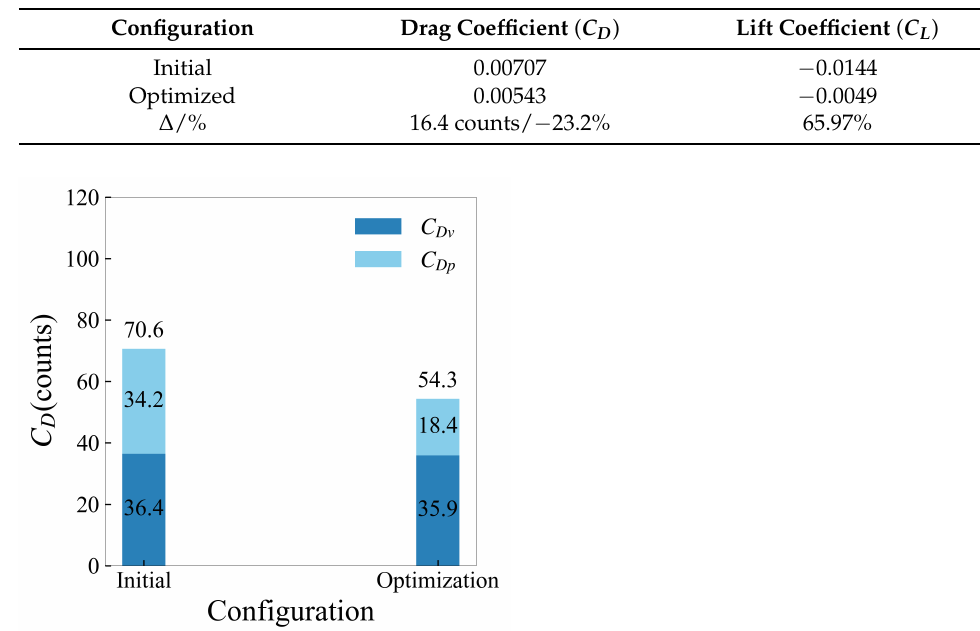
Figure 12. History of optimization for military transport aircraft. Table 4. Optimization results for military transport aircraft.